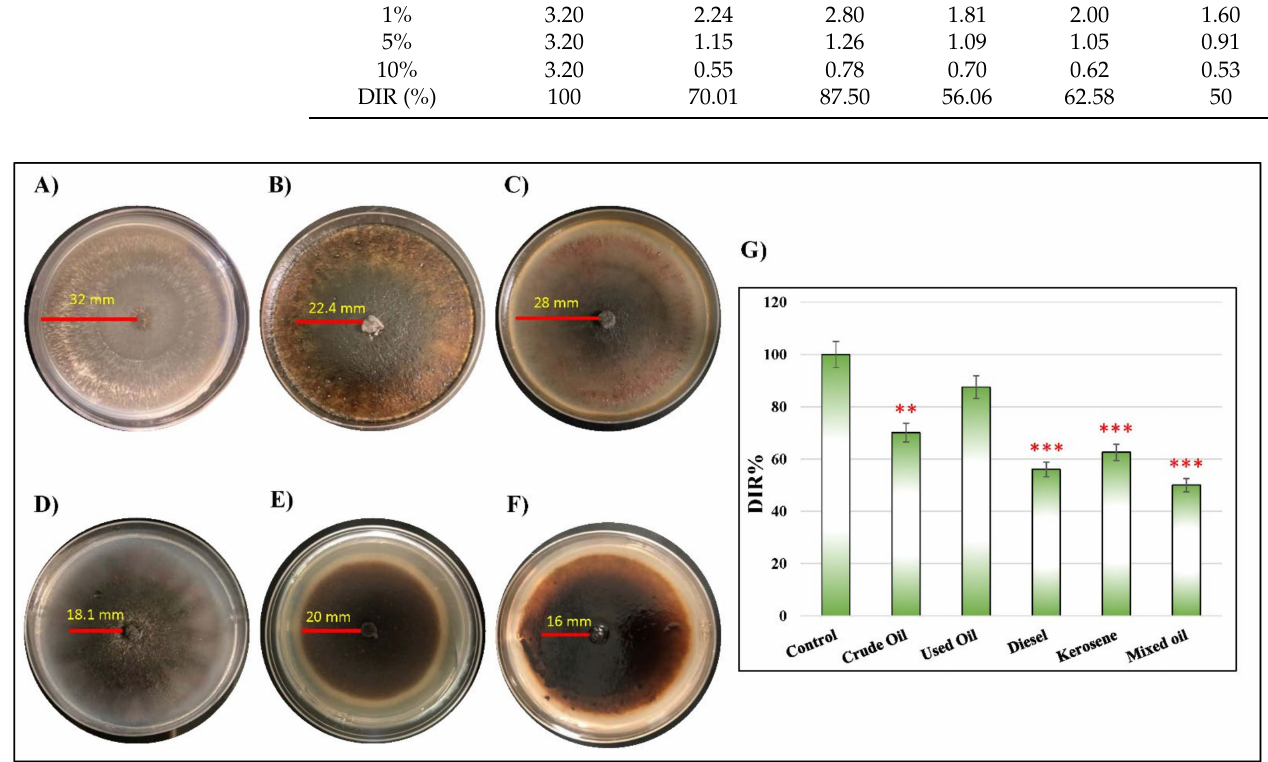
Figure 1. The ability of D. spicifera to tolerate effects of different hydrocarbons in solid medium. The fungal growth was tested in solid medium of MSM supplemented with 1% of different